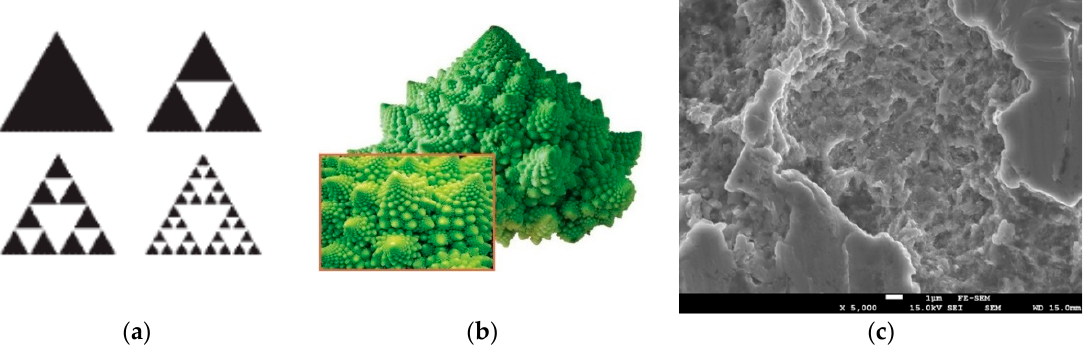
Figure 3. Types of self-affine fractal transformations: ( a ) self-similar; ( b ) quasi self-affine; ( c ) statistically self-affine.